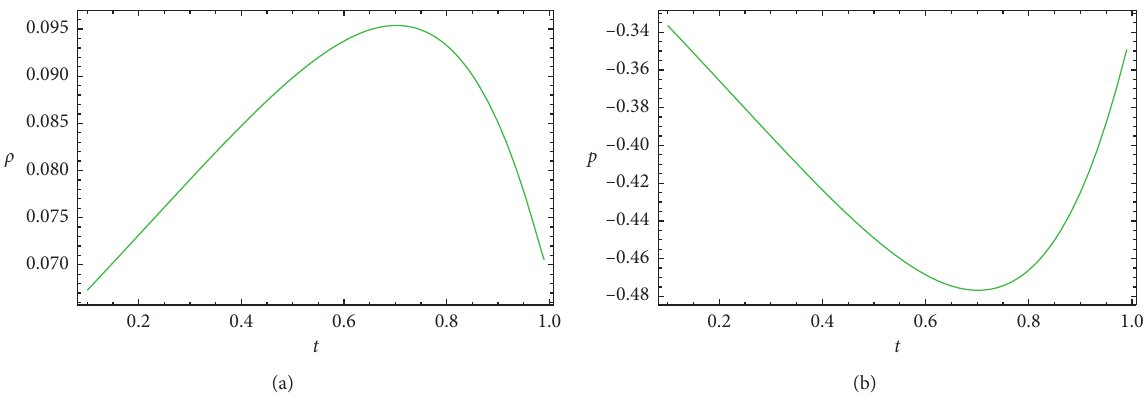
Figure 7: Energy density and pressure profiles for ω λ � 0 . 5 ; r � − 0 . 0005 ; s � 5.